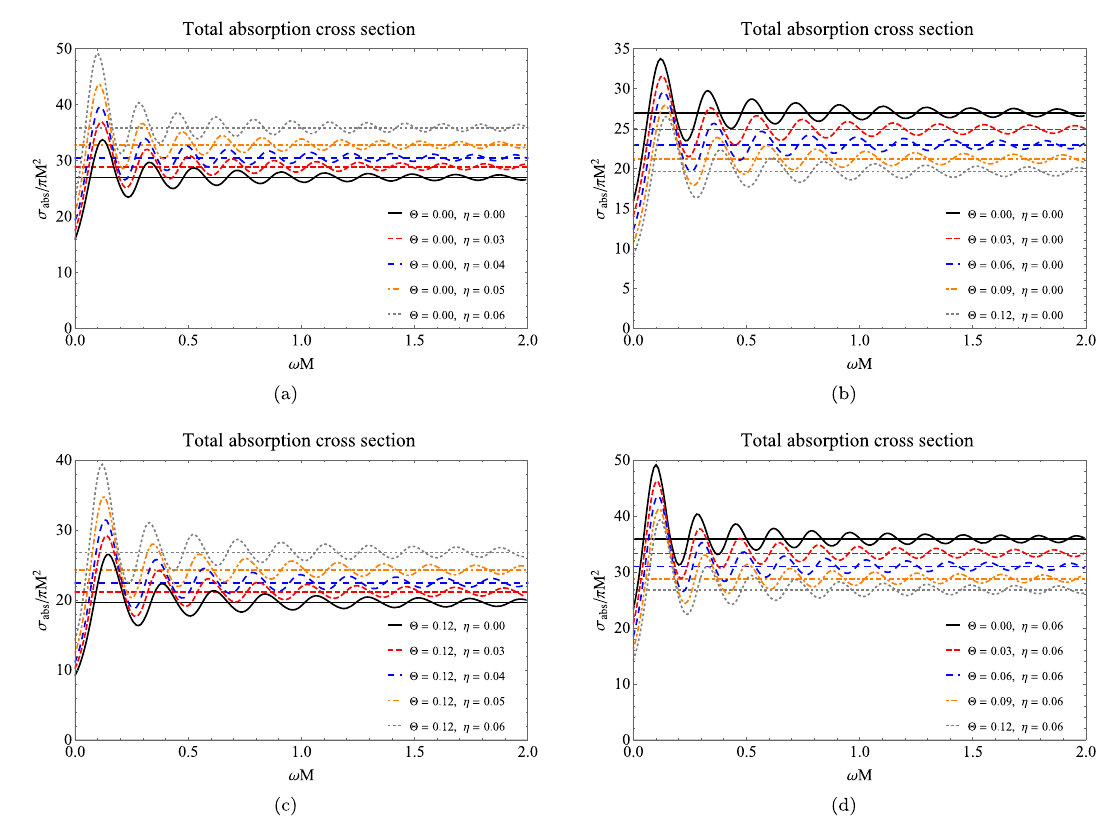
Fig. 6 Total absorption cross section. The lines represent the values for high frequency absorption, the values obtained by the null geodesics are: a 27 . 0 , 28 . 9 , 30 . 5 , 32 . 8 , 35 . 9, b 27 . 0 , 24 . 9 , 23 . 0 , 21 . 2 , 19 . 6, c 19 . 6 , 21 . 2 , 22 . 5 , 24 . 3 , 26 . 8 and d 35 . 9 , 33 . 4 , 31 . 0 , 28 . 8 , 26 . 8